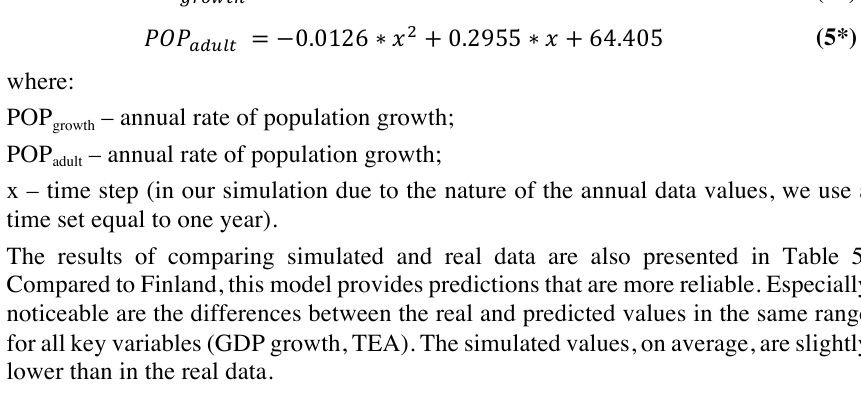
Table 3 . Average absolute errors in simulated